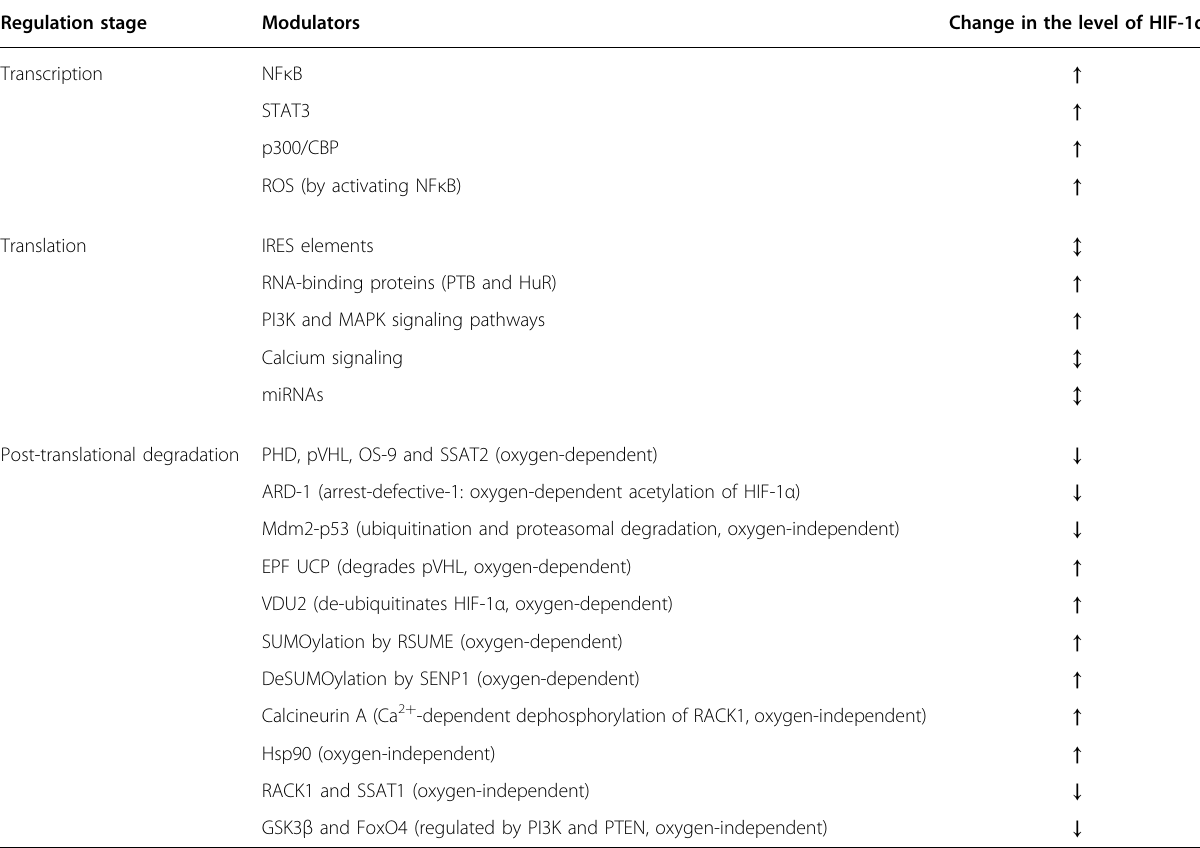
Table 2 Factors that regulate the abundance and activity of HIF-1 α Regulation stage